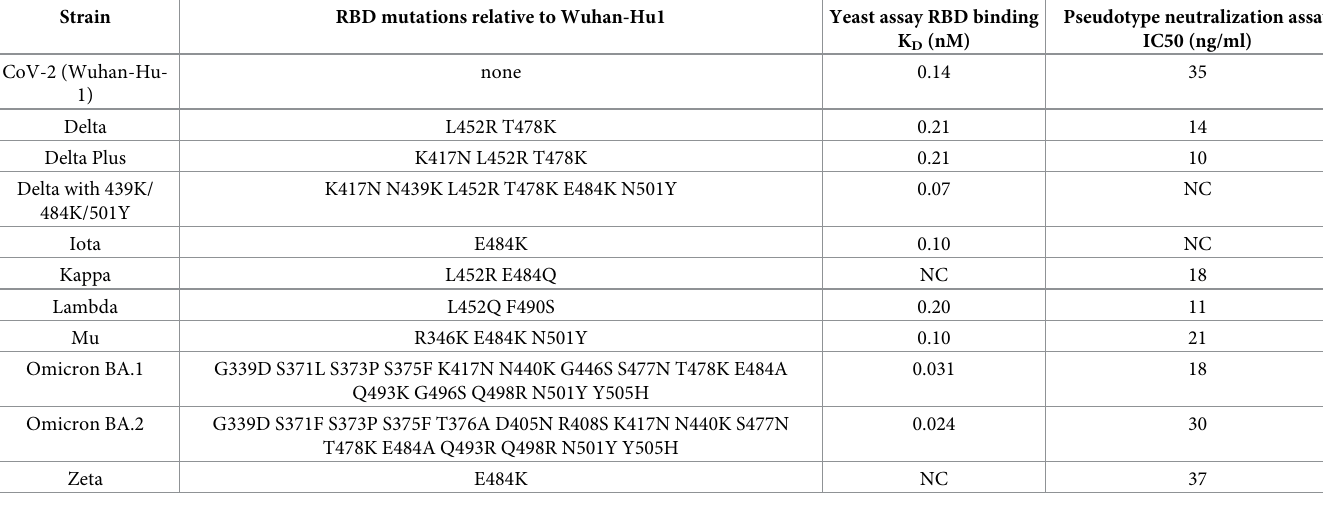
Table 1. RBD binding constants and neutralization IC50 values for CDY14HL-Fc1 vs SARS-CoV-2